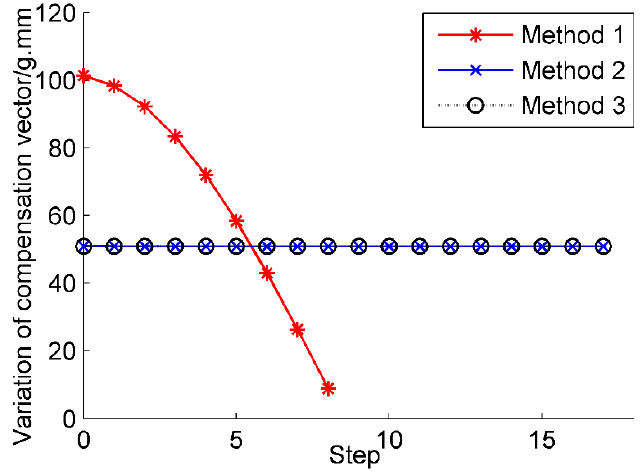
Figure 8. Diagram of balancing accuracy analysis.